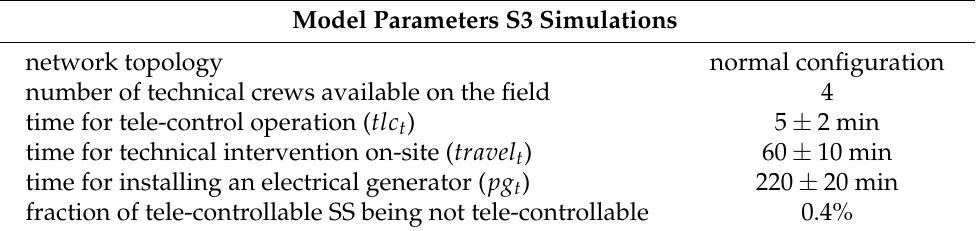
Table 4. Parameters used for S3 ( high traffic ) simulation.